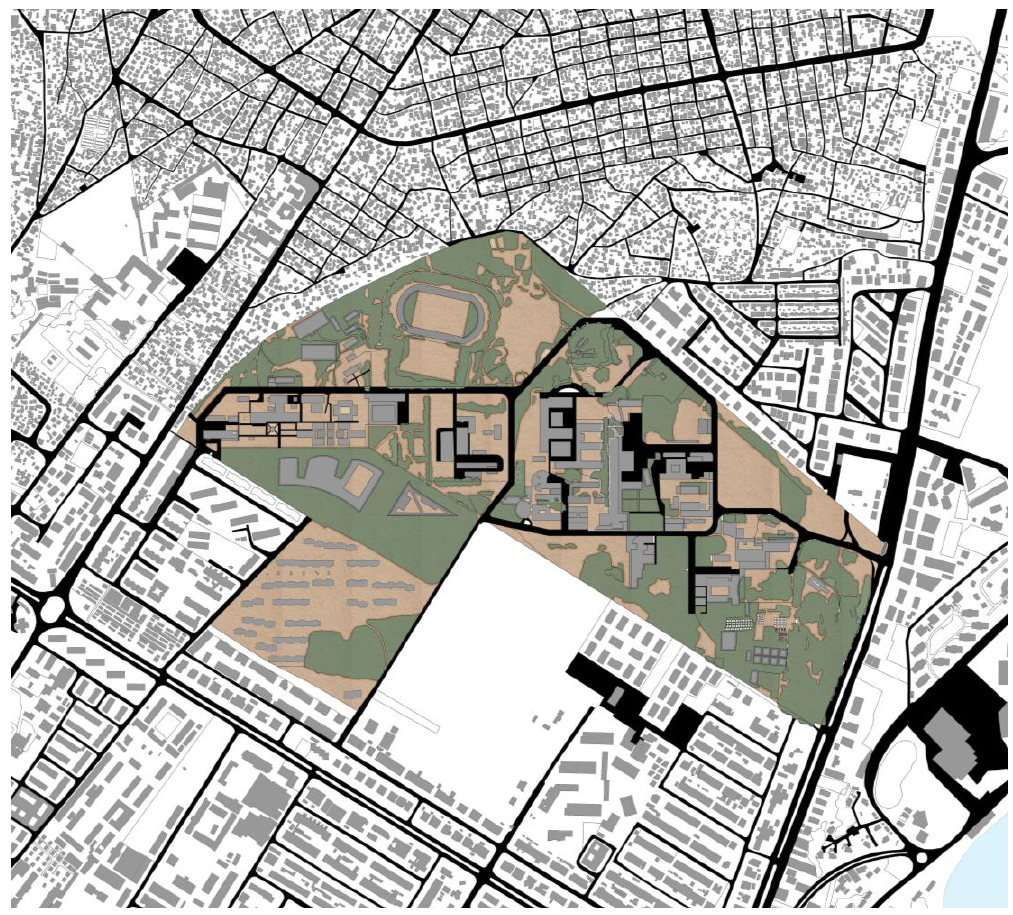
Figure 1. The Sommerschield district in 2017. The UEM Campus is highlighted in the centre of the area. Behind the north boundary there is the informal development.